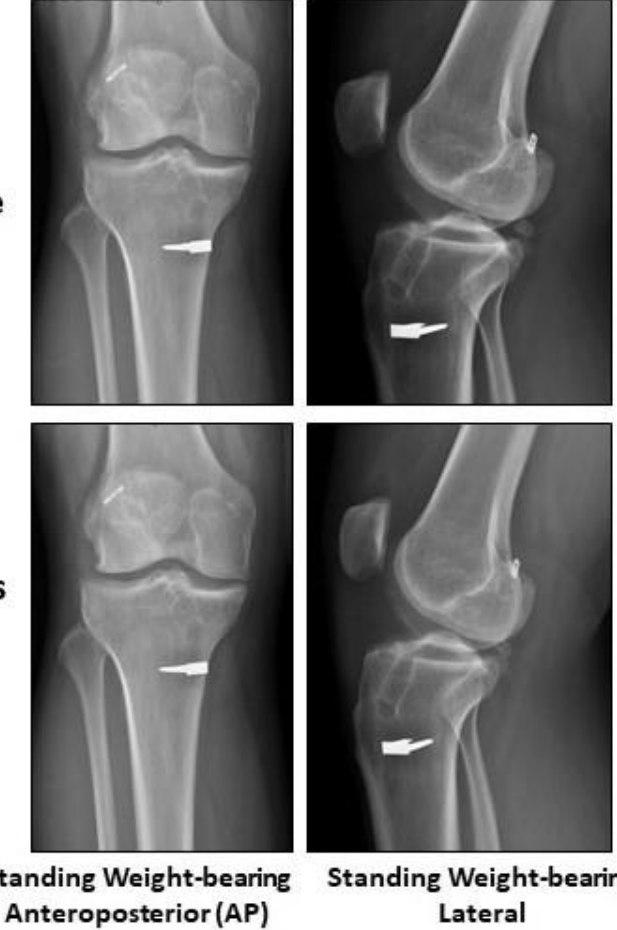
Figure 1. Plain Radiography. No significant difference nor progression in OA via X-Rays was observed.